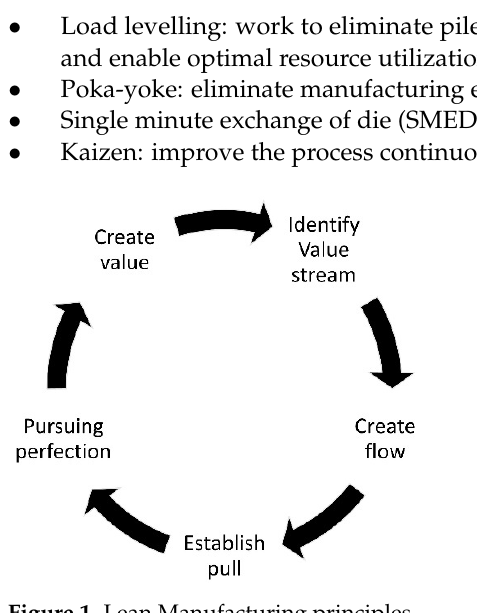
Figure 1. Lean Manufacturing principles.